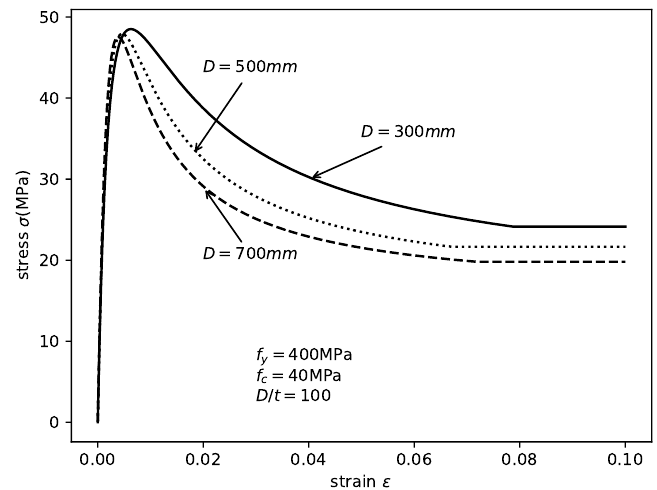
Figure 7. Size effect on the stress–strain relation of confined